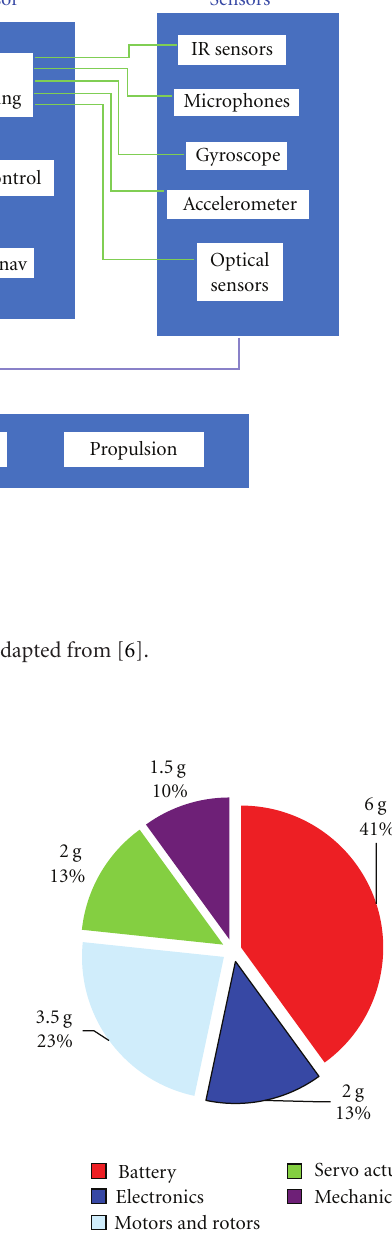
Figure 6: AVS weight budget allocation: the first number is the weight in grams while the second one is the percentage with respect to the total weight of 15g, adapted from [2,